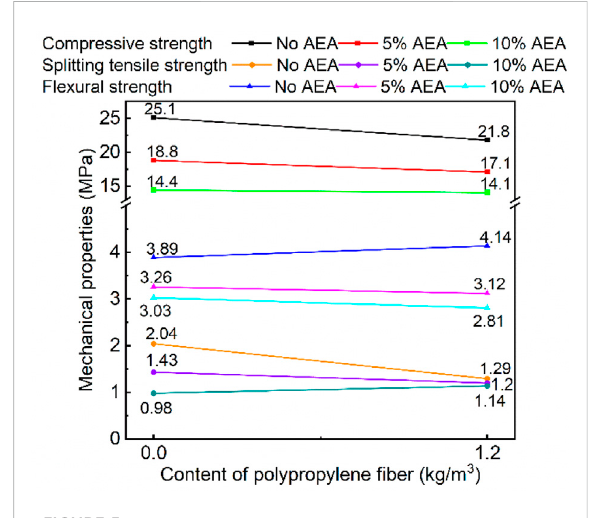
FIGURE 5 Effect of polypropylene fi ber on mechanical